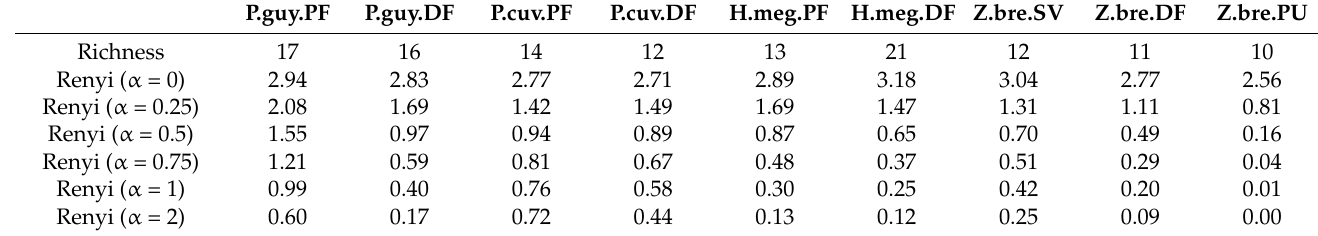
Table 3. Richness and R é nyi’s entropy values for different values of α between 0 and 2 for the nine species–habitat combinations.